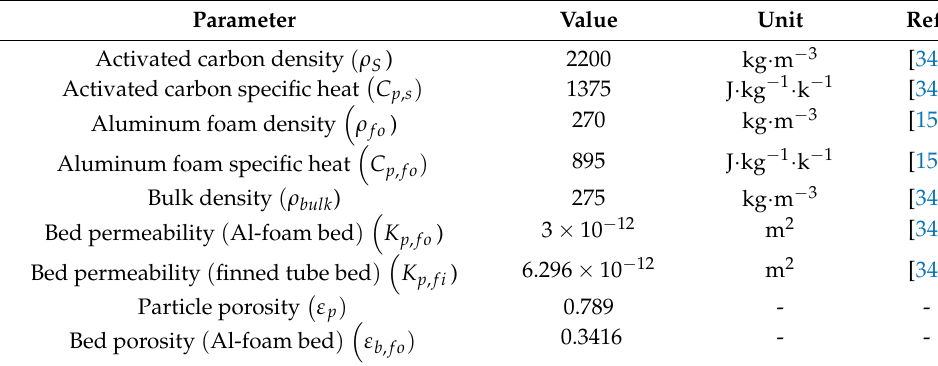
Table 1. The main parameters used in the